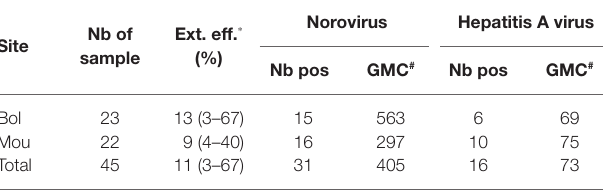
TABLE 1 | Detection and quantification of norovirus and hepatitis A in collected